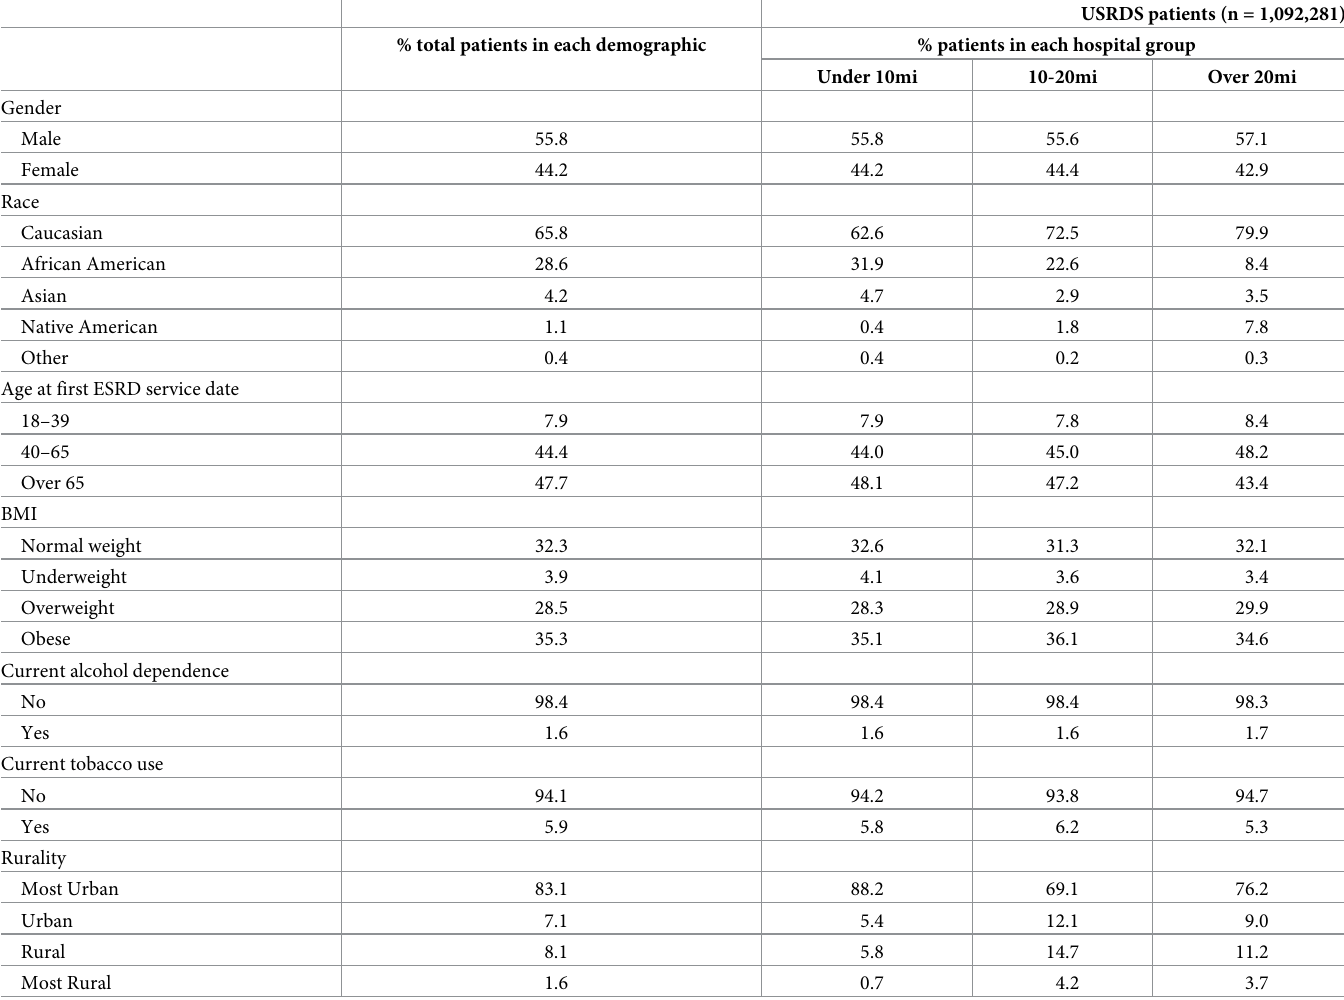
Table 1. Demographic characteristics of 1,092,281 ESRD patients from 2000 to 2013 stratified by distance to the nearest